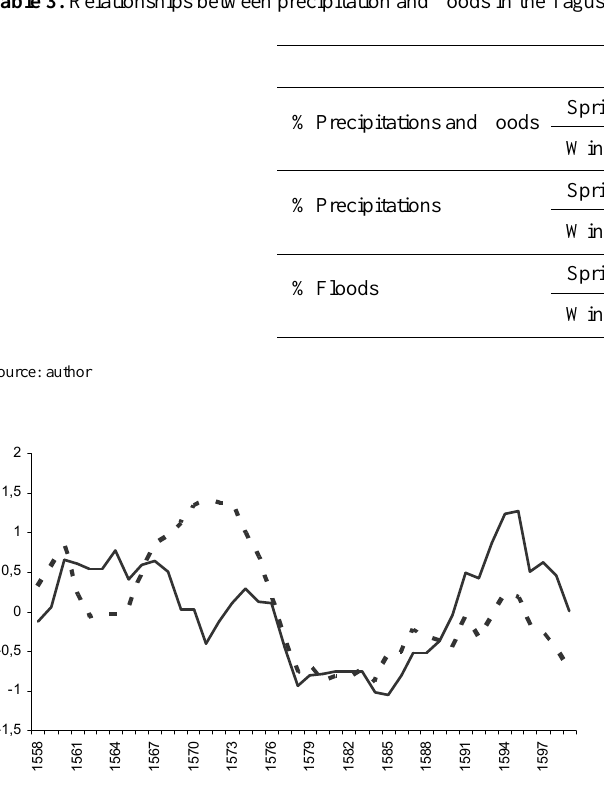
Fig. 5. Sequential Mann- Kendall curves of precipitations. Normal Figure 5. Sequential Mann- Kendall curves of precipitations. Normal series (solid line), series (solid line), backward series (broken line). Tagus and Duero backward series (broken line). Tagus and Duero basins. Y-axe =Man-Kendall index (u t ) basins. Y-axis = Man-Kendall index (u t ) and (u t 0 ) ; X-axis = yr. and (u t’ ) . X-axe= years.